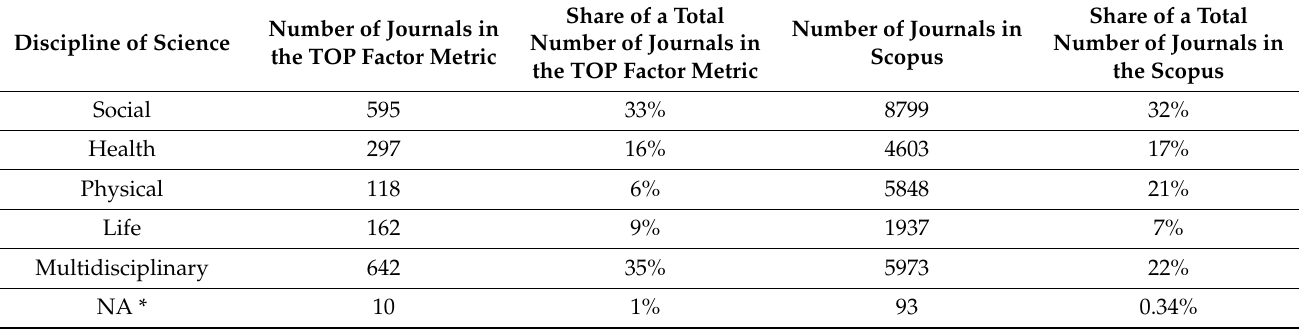
Table 2. Number and percentage of discipline-specific journals in the TOP Factor metric and Sco- pus